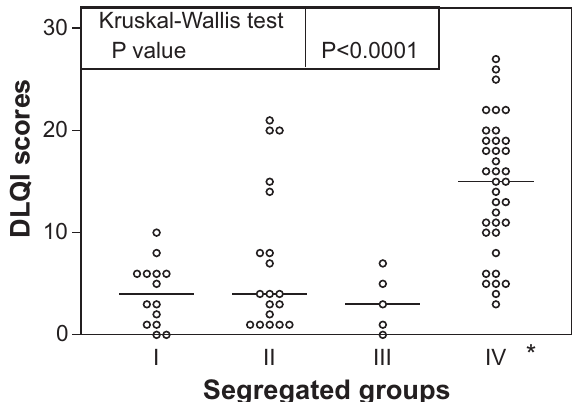
Figure 4 - Quality of life measured by specific dermatological test DLQI, in groups segregated according to methods and fig.3. Bars represent the mean values of each group. Inserted table shows statistical comparison between groups, with (*) marking post-test significance.